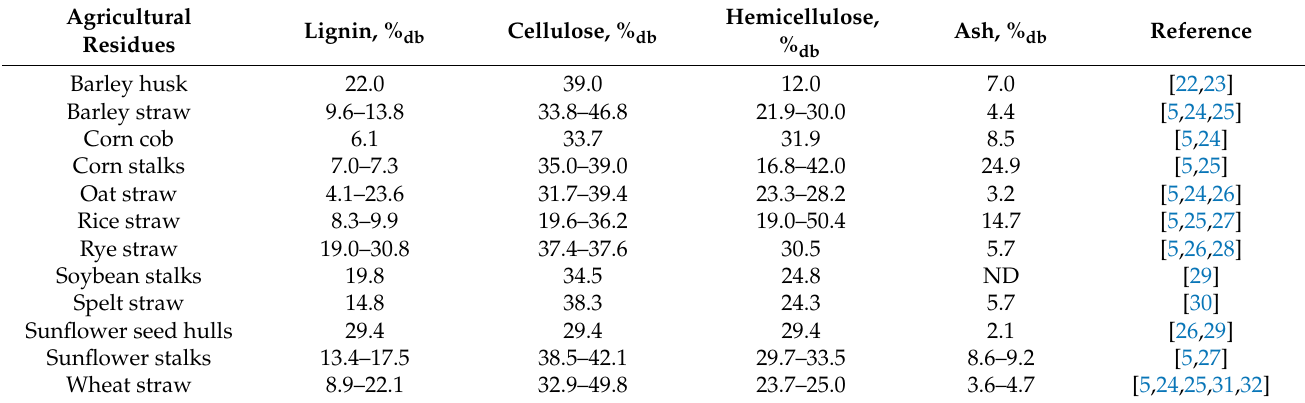
Table 1. Chemical composition of common agricultural